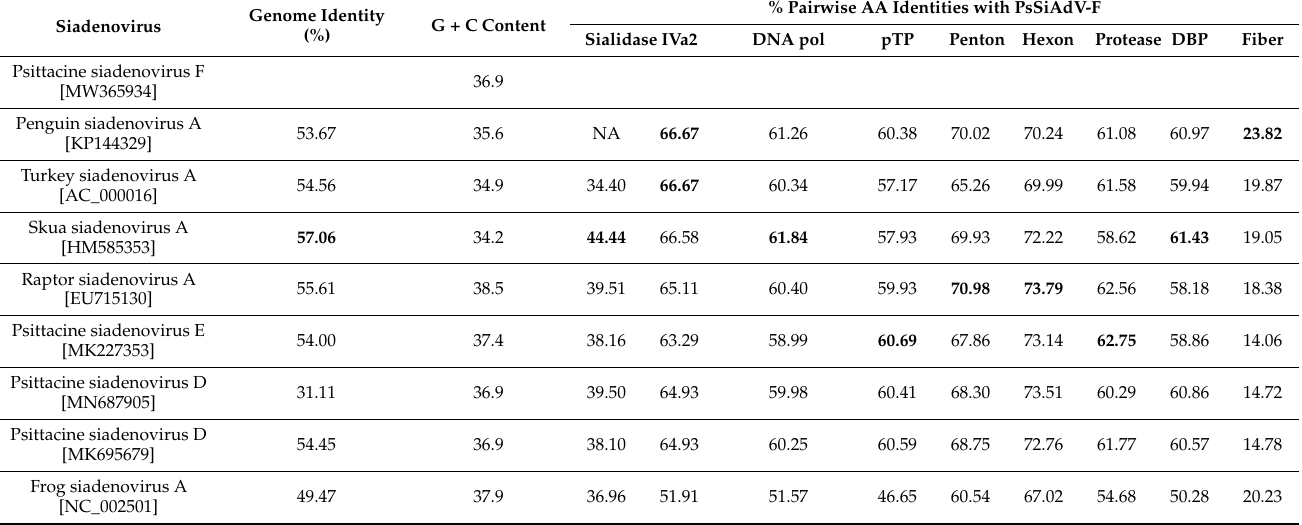
Table 2. Pairwise identity and comparative G + C (%) content analysis of representative siadenovirus species against PsSiAdV-F based on amino acid sequences of selected core proteins and complete genome sequences. Highest identities are highlighted with bold